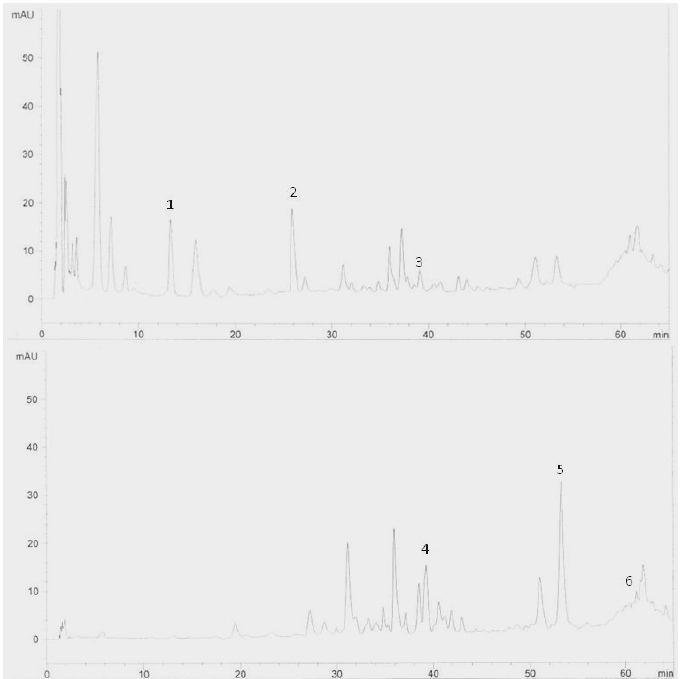
Figure 2. HPLC chromatogram of Zingiber officinale variety Halia Bara extracts (rhizomes). Identification of compounds: catechin (1), epicatechin (2), naringenin (3), rutin (4), quercetin (5) and kaempferol